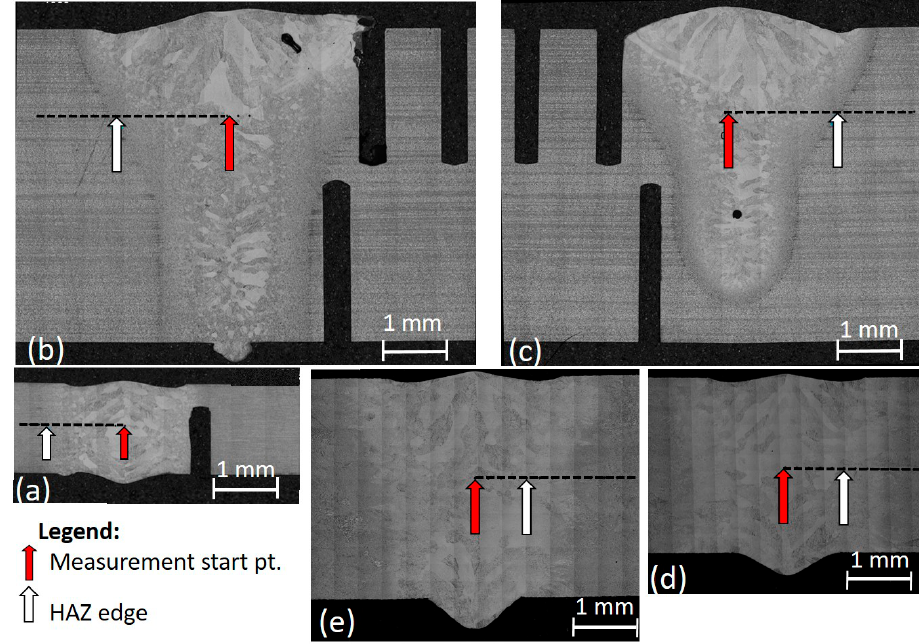
Figure 3. Micrographs of sectioned weld pools for each of the instrumented welds performed ( a – e ), the weld parameters for which are shown in Table 2.